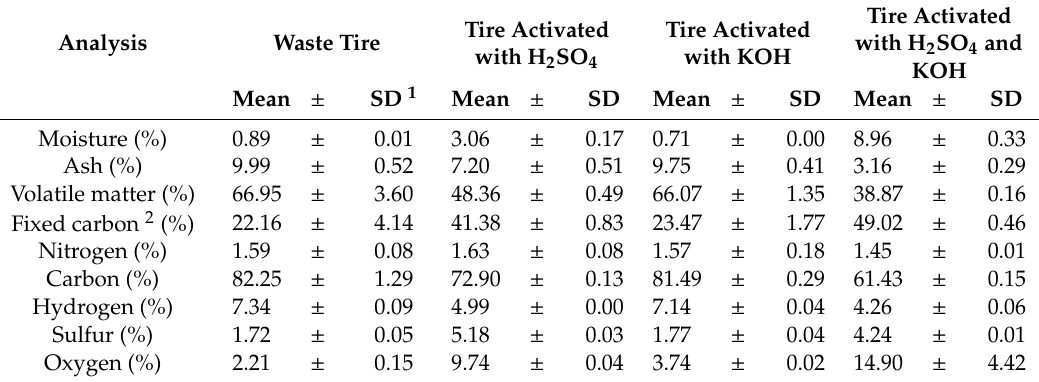
Table 1. Proximal and elemental analysis results from waste tire used as feedstock. Analysis Waste Tire